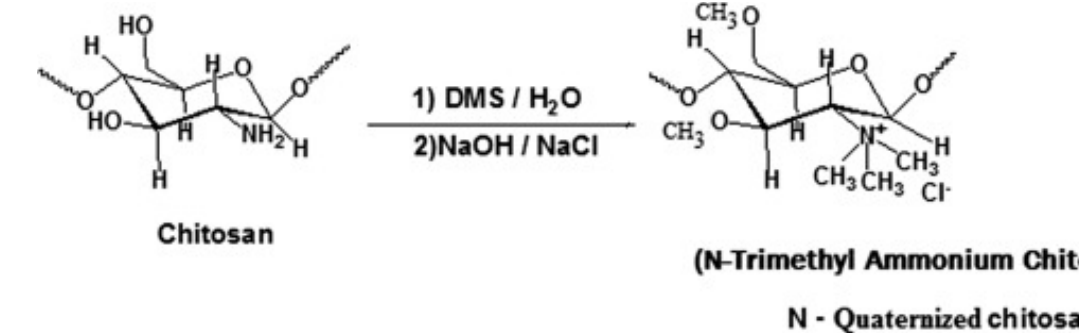
Figure 5. Synthesis of quaternized chitosan (DMS–dimethylsulfate) [198]. Reproduced with permission from Elsevier (Copyright©2015).